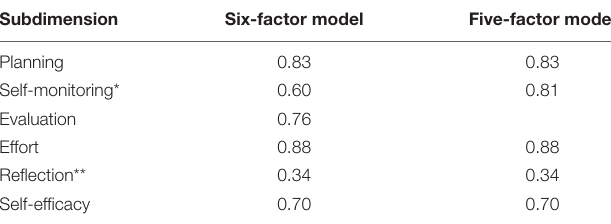
TABLE 4 | Internal consistency of each factor within each measurement model.